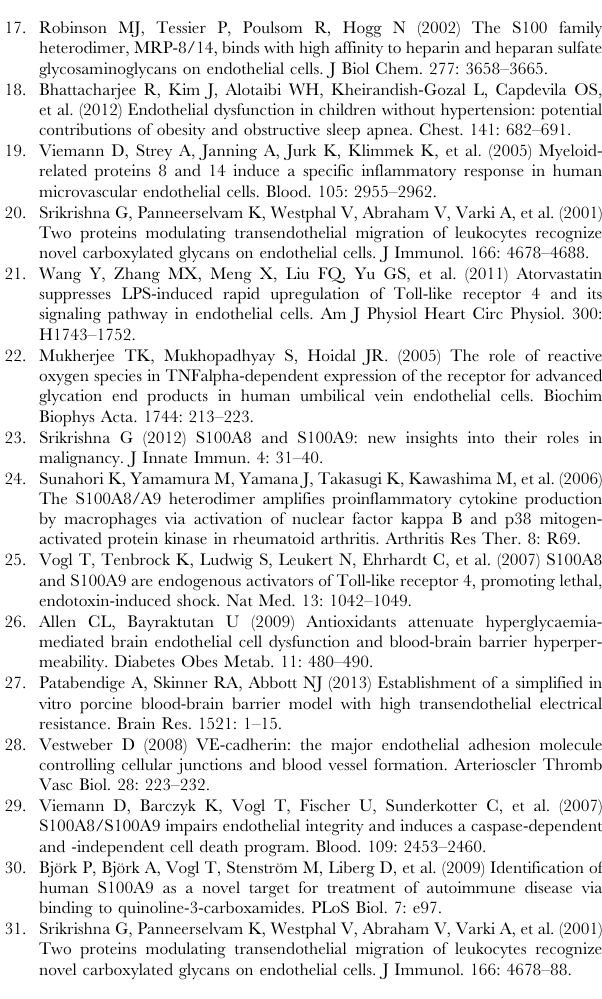
4.0) ( C ) respectively. The TER was measured every 10 min. All data are presented as mean 6 s.d. of four independent experiments. * P , 0.05 vs. Control. (TIF) Figure S2 S100A8, S100A9, or S100A8/S100A9 were heat-inactivated at 80 6 C for 30 minutes. HUVEC mono- layer was stimulated for 120 min with inactivated S100A8 (2.0 m g/ml), S100A9 (2.0 m g/ml) or, S100A8/S100A9 (2.0 m g/ ml) respectively. TER was then measured. All data are presented as mean 6 SD of four independent experiments (A). Phosphor- ylation of ERK1/2 (P-ERK1/2) was assessed by Western blotting. The ratio of immunointensity between the phosphorylation of ERK (P-ERK) and total ERK was calculated from three independent experiments (B). * indicated P . 0.05. Figure S3 The expression of TLR4 and RAGE in HUVECs used in this experiment. Cells were maintained in DMEM/F12 containing 10% FBS and grown to 90% confluence. HUVECs were starved of serum for 12 hours then lysised with SDS loading buffer. The expression of TLR4 and RAGE were assessed by Western blotting with primary antibodies for TLR4 (1:1000, Cat. AF1478) and RAGE (2 ug/ml, Cat. MAB11451) (R&D Systems, Minneapolis, MN). (TIF)